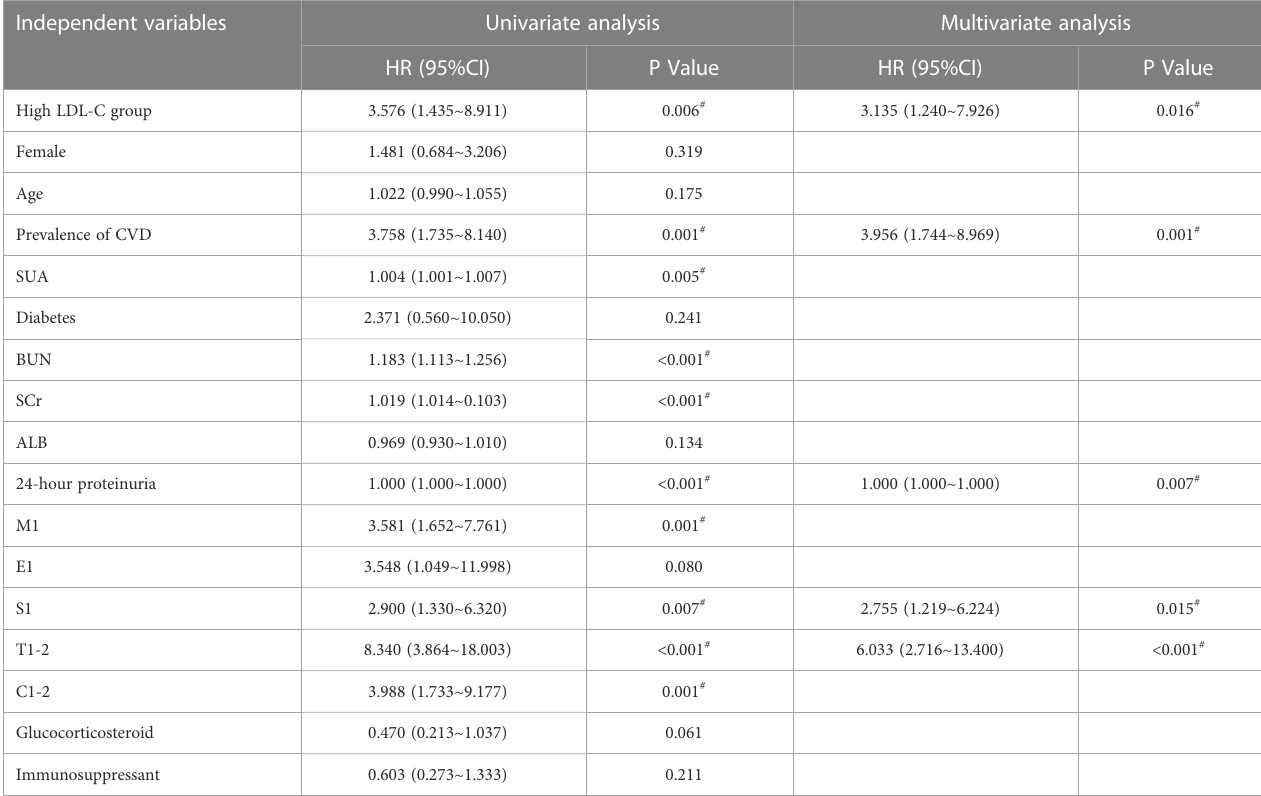
TABLE 2 Analysis of factors in fl uencing poor renal prognosis in patients with IgAN (Cox regression equation). Independent variables